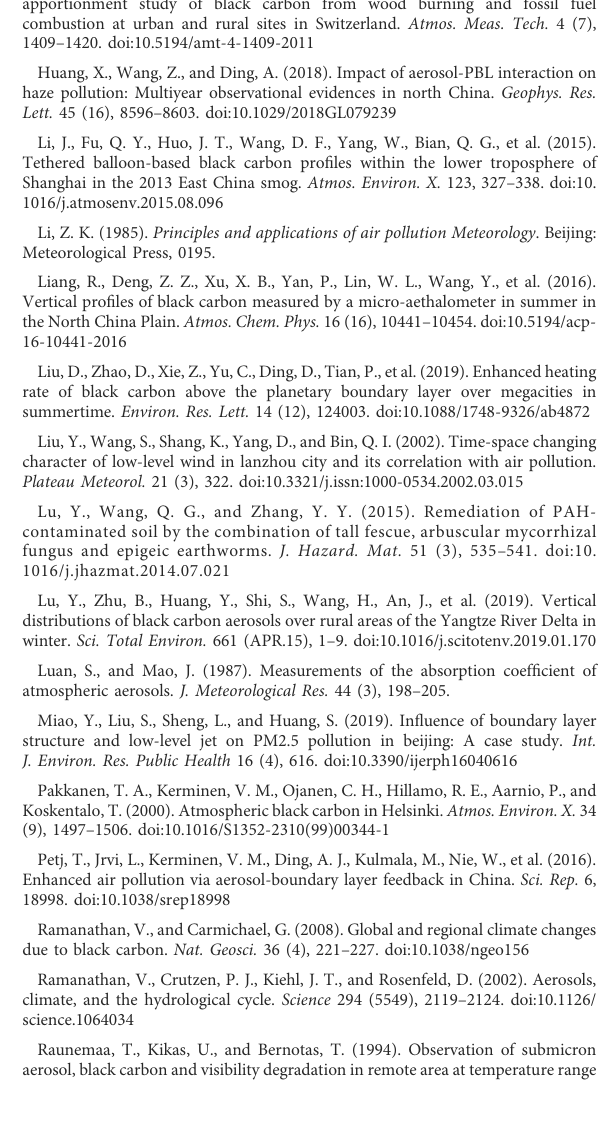
Comparison of ground black carbon concentration observations between AE-33 and AE-51 black carbon measuring instruments. SUPPLEMENTARY FIGURE S3 Schematic diagram of the evolution of the boundary layer (Stull, 1988). SUPPLEMENTARY FIGURE S4 Average virtual potential temperature pro fi le of a typical pro fi le (Stull, 1988).Stull R.B. Anintroductionto boundarylayermeteorology. Klumer Academic Publishers, Dordretch, 665pp, 1988. SUPPLEMENTARY FIGURE S5 Changes of surface pollutants and meteorological parameters over time from 1 January to 4, 2017 Relative humidity, precipitation, temperature (B) BC aerosol, wind direction, wind speed. SUPPLEMENTARY FIGURE S6 Backward trajectory diagram of 00:00 on 2 January forward 24